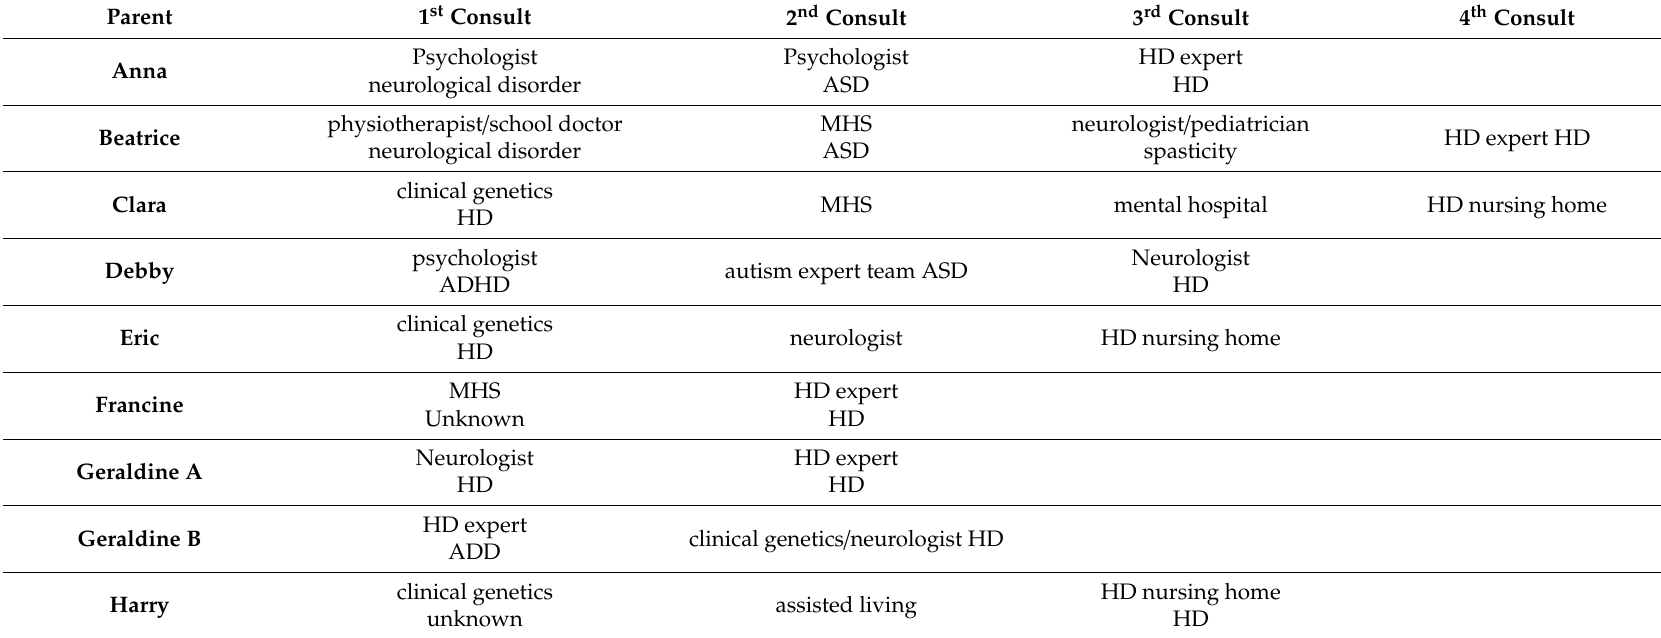
Table 2. Diagnostic process by